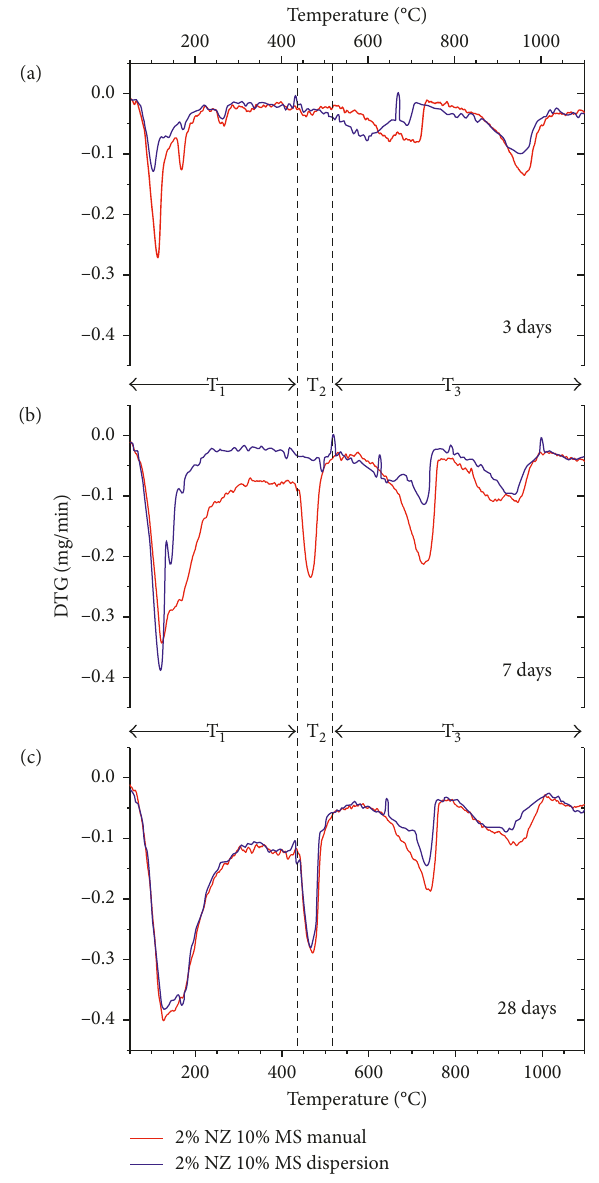
Figure 4: DTG-T a analysis for cement paste with 2 wt.% of nanozinc (NZ)+10 wt.% microsilica (MS) for (a) 3, (b) 7, and (c) 28